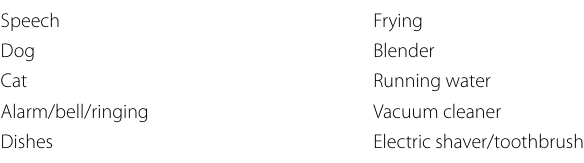
Table 1 Labeled sound categories in data set Speech